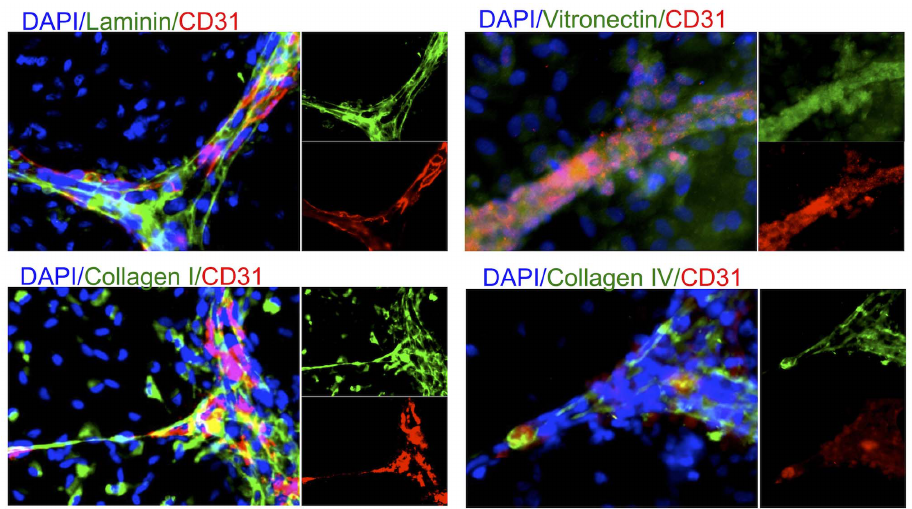
Figure 8. Deposition of a basement membrane and presence of tight junction molecules. Characteristic extracellular matrix molecules, such as laminin, vitronectin, collagen I and IV, delineate the basement membrane which separates the vascular-like structures from the neural environment.